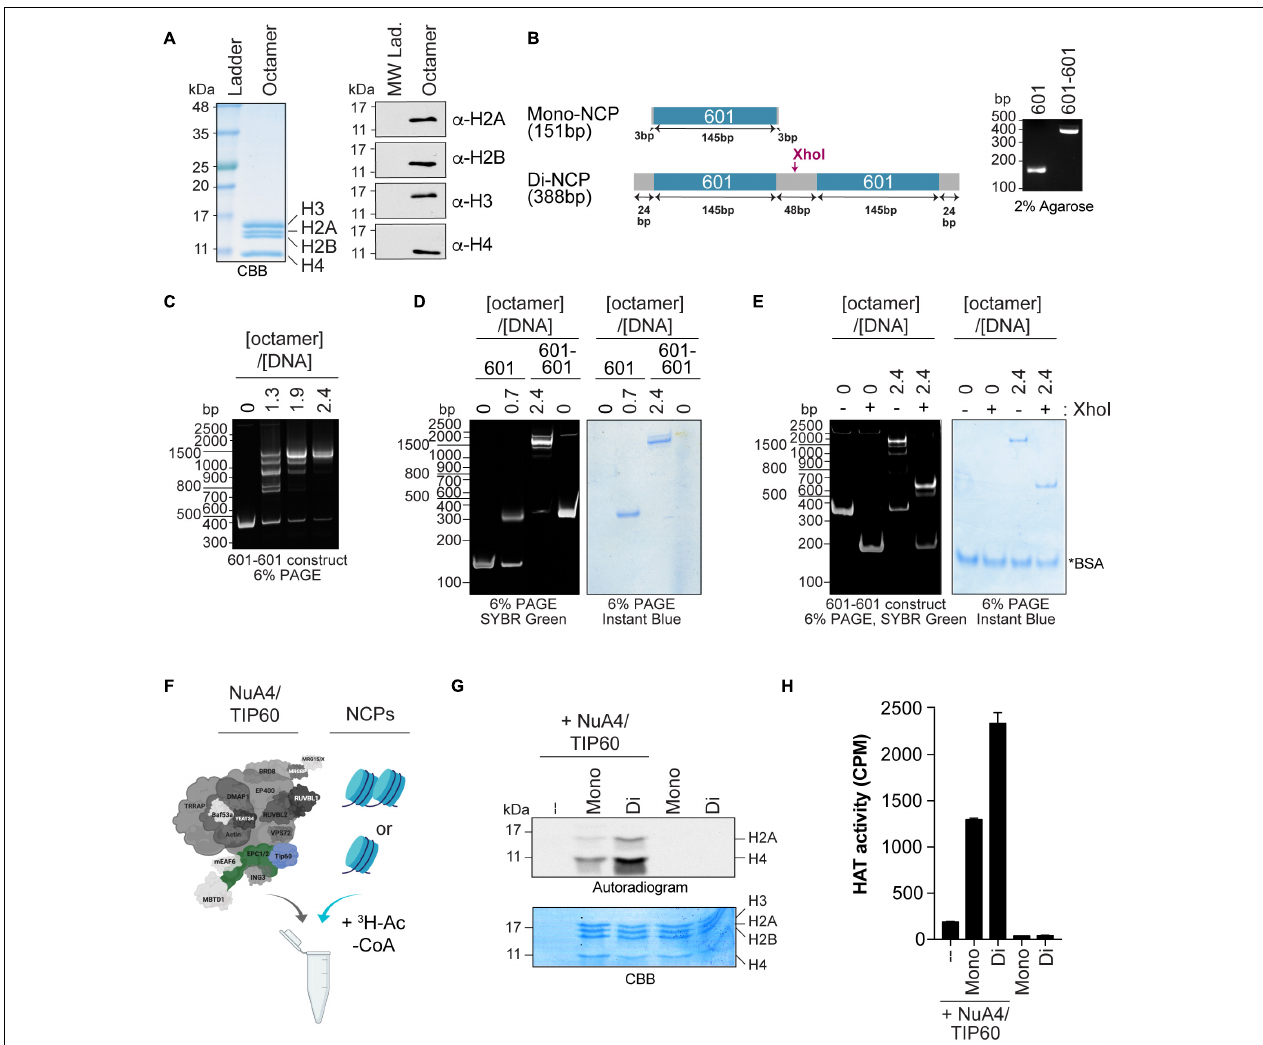
FIGURE 2 | Quantifying the HAT activity of native complexes on recombinant nucleosomes (A,B) . Analysis of the octamers and 601 DNA used to reconstitute NCPs. (A) Coomassie Brilliant Blue (CBB) staining (left panel) and western blot analyses (right panel) of refolded octamers. (B) Schematic representation of the Widom 601 DNA sequence used to wrap mono- and di-NCPs (left panel). The position of the XhoI cleavage site used to validate di-NCP assembly is indicated. Purified DNA obtained from a large prep purification was resolved on a 2% agarose gel and stained with ethidium bromide (right panel). (C–E) Analysis of 200 ng of NCP reconstitution on native gels stained with either SYBR green or InstantBlue Coomassie Stain. 200 ng of DNA alone (0) is used as a control. (C) Refolding of di-NCPs using the indicated octamer:DNA ratios. (D) Mono- and di-NCPs refolded at their optimal octamer:DNA ratios. (E) Di-NCPs treated with XhoI for 1 h. The cleaved form of the 601-601 DNA is observed at approximately 200 bp. *BSA used in the reaction. (F–H) HAT assay using NuA4/TIP60 complex purified using EPC1-tagged subunit and reconstituted NCPs. The TIP60 subunit, which encompasses the acetyltransferase activity of the complex, is colored in blue and the tagged subunit EPC1 is colored in green. Created with BioRender.com. (F) Schematic representation of the HAT assay. (G) Autoradiogram showing the HAT activity of 1 µ L of purified native NuA4/TIP60 complex on histone H2A and H4. The gel was kept with the X-ray film at –80 ◦ C for 4 days. Coomassie Brilliant Blue (CBB) staining was used to show equal loading. (H) Quantification of a representative experiment ( n = 3). HAT reactions were spotted on P81 filters and analyzed with a scintillation counter. Error bars indicate the range between technical duplicate